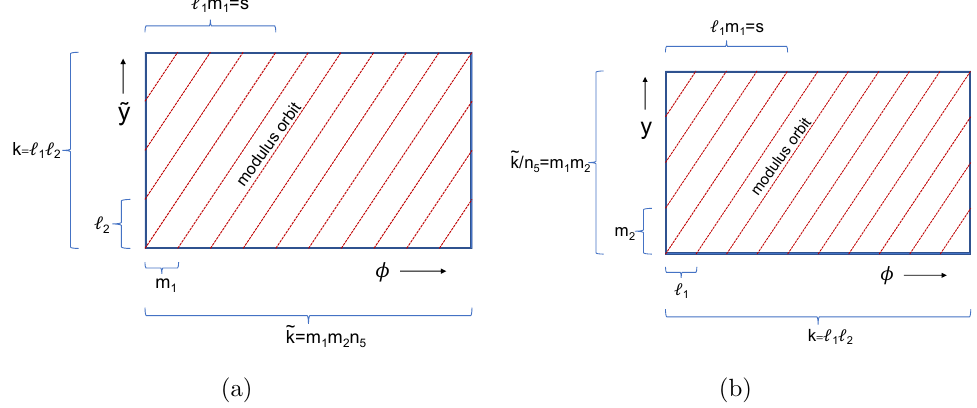
Figure 13. (a) Brane moduli space on the ~ y - (cid:30) torus. There is an equivalent picture for the ~ y - torus, with ‘ 1 $ ‘ 2 and m 1 $ m 2 . (b) The T-dual picture on the y - (cid:30) torus exchanges the roles of k and ~ k = m 1 m 2 n 5